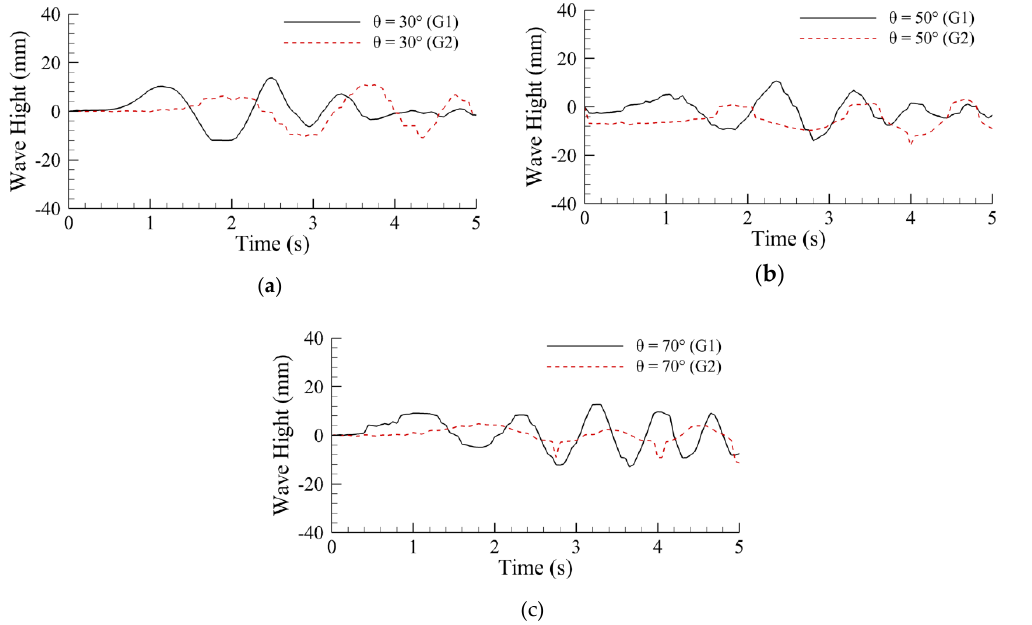
Figure 12. The temporal evolution of the water elevation in G 1 and G 2 with the partial subaerial landslide: ( a ) θ = 30 ◦ ; ( b ) θ = 50 ◦ ; and ( c ) θ = 70 ◦